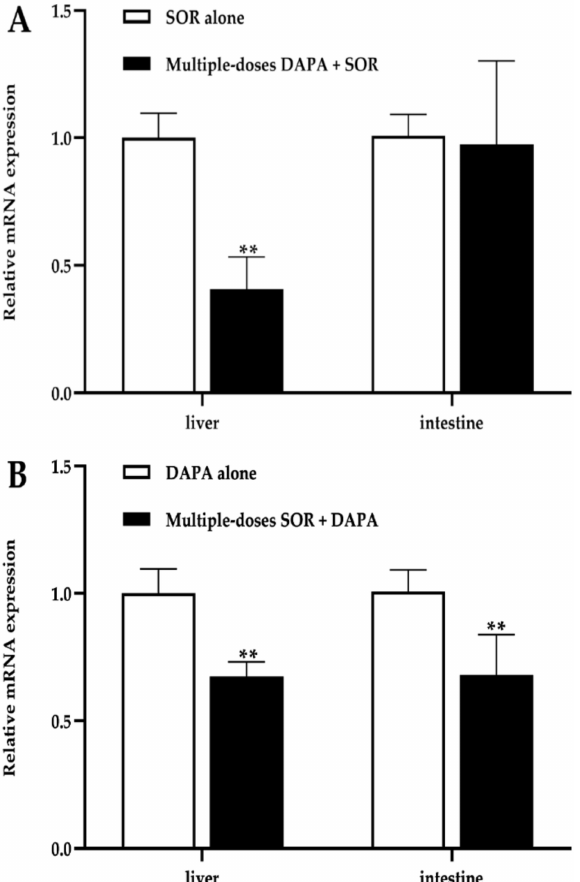
Figure 4. mRNA relative expression ratio of Ugt1a7 in the liver and intestines of rats. ( A ) Effect of multiple-doses DAPA treatment on mRNA expression of Ugt1a7; ( B ) Effect of multiple-doses SOR treatment on mRNA expression of Ugt1a7. ** p <